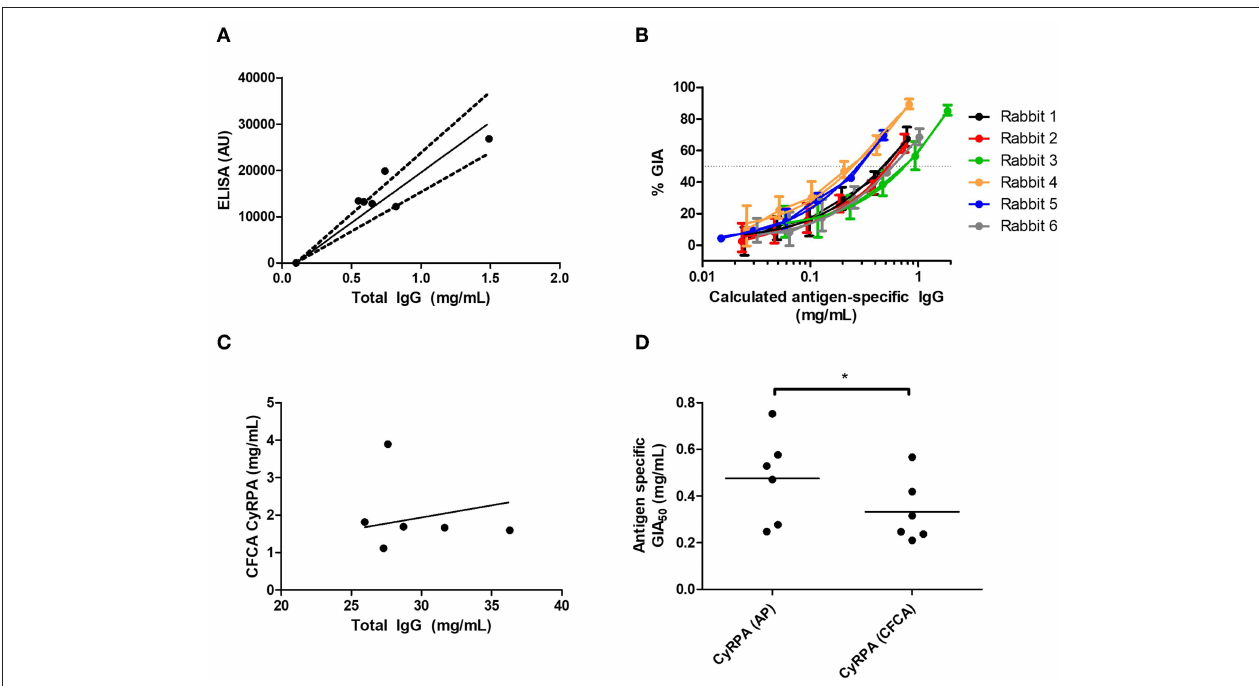
FIGURE 6 | Potency of vaccine-induced anti-CyRPA antibodies from six individual rabbits. See Figure S8 for experimental schematic. A second batch of IgG was purified from the six rabbits shown in Figures 5E,F , as well as one pool of pre-immune IgG, using protein G. (A,B) Calculation of antigen-specific IgG concentration by affinity purification (AP) and ELISA analysis. (A) Total IgG from six individual rabbits was passed over a CyRPA-sepharose column and the six eluates were analyzed for total protein concentration by OD 280 , and assayed for CyRPA binding by ELISA, to generate a conversion factor for each rabbit. Points are individual rabbits, solid line is mean conversion factor (shown for information only—not used in calculations), dashed lines 95% CI (actual calculations were performed with separate conversion factors for each individual rabbit). (B) GIA data from Figure 5E transformed using the conversion factors determined for individual rabbits in panel A, to show CyRPA antigen-specific IgG concentration. Points are means of 3 assay well replicates, error bars show range of three replicates. (C) Calibration-free concentration analysis (CFCA). Total IgG was analyzed for total protein concentration by OD 280 , and anti-CyRPA antigen-specfic IgG concentration by CFCA. Pre-immune IgG gave a sub-detectable CFCA response. (D) Interpolated GIA EC 50 s for the six CyRPA immunized rabbits. Points are individual rabbits, bars are